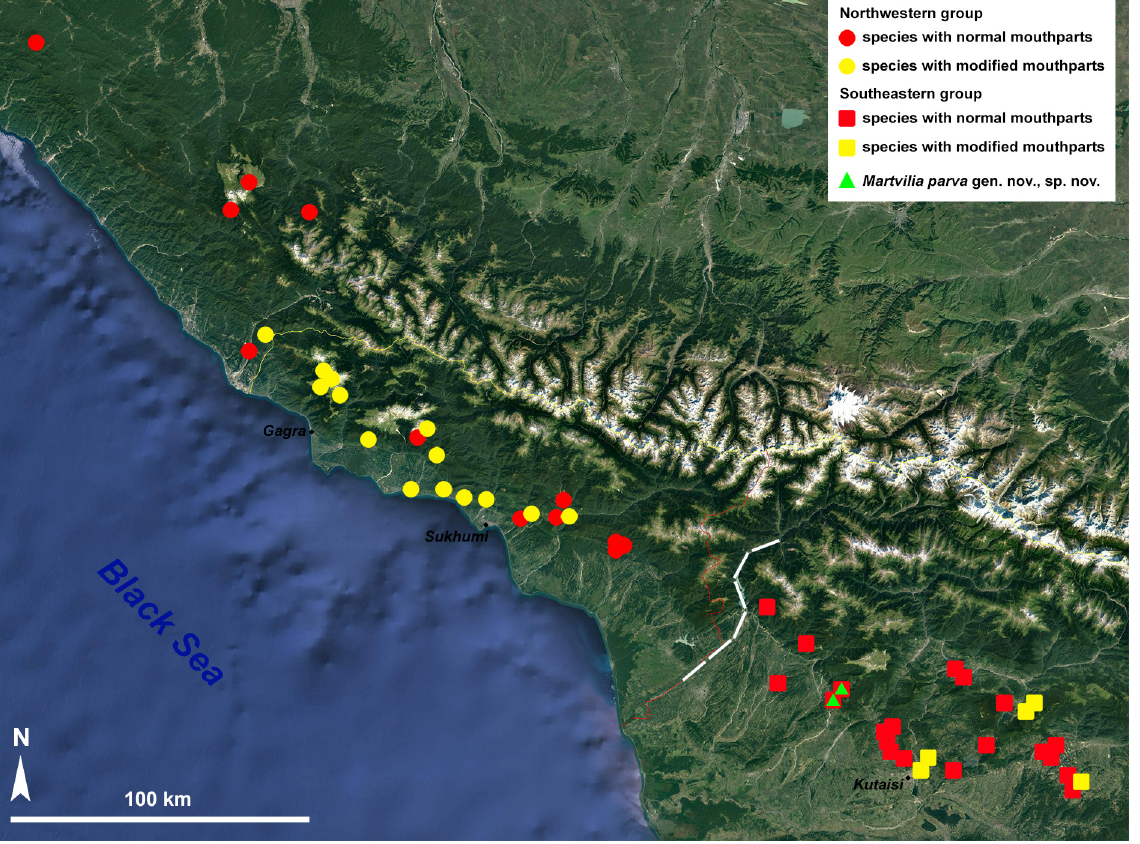
Fig. 56. General distribution of the Caucasian leucogeorgiinines. The white dashed line hypothetically indicates the boundary between the northwestern and southeastern groups of species of the genus Leucogeorgia Verhoeff,